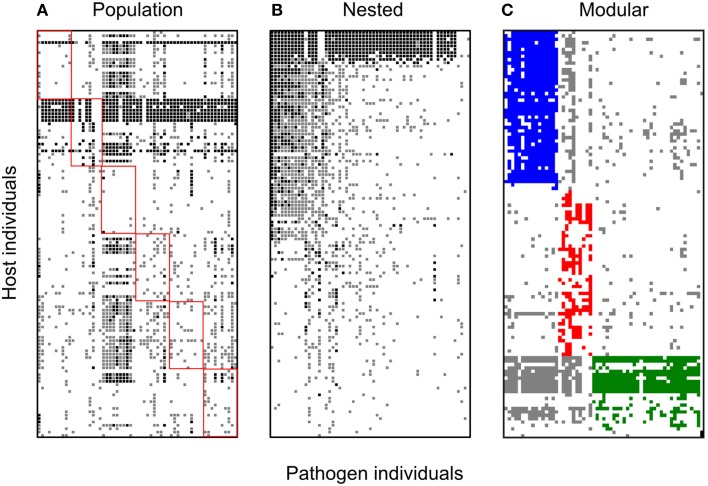
Bipartite spatial networks for the Linum-Melampsora local adaptation dataset. Black squares indicate full resistance, gray squares indicate partial resistance, and white squares indicate full susceptibility. Hosts are represented on the Y-axis and pathogens on the X. All panels are formed from the same base dataset but sorted in different ways so as to facilitate visually testing different network hypotheses: (A) sorted by population of origin. Host and pathogen interactions corresponding to the same population are indicated by red squares; (B) sorted to maximize nestedness; and (C) sorted to maximize modularity. The network is significantly nested (NODF; P < 0.001). For the modularity sorting, discrete modules are shown in different colors (blue, red, green, black). Four modules could be identified in this network with the P-value for observed modularity less than 0.0001.